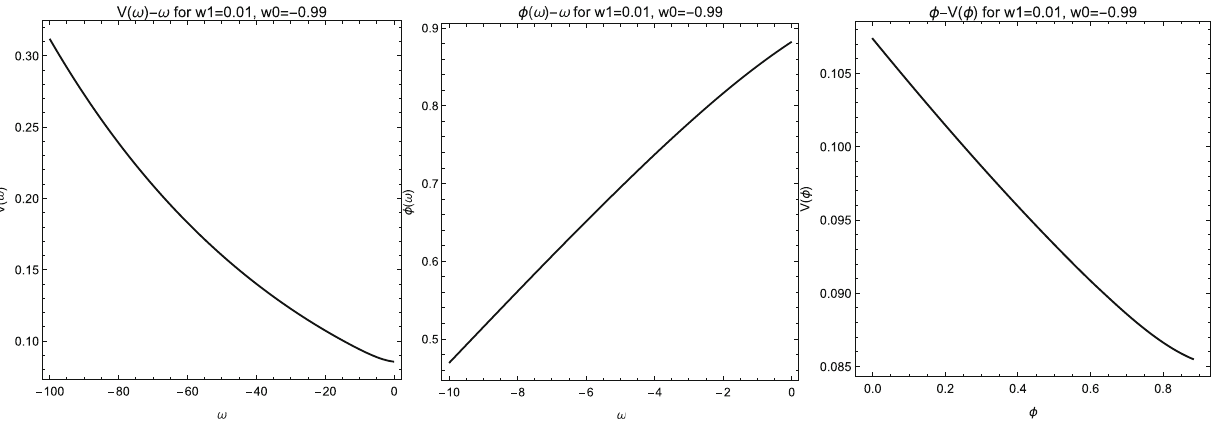
Fig. 5 Qualitative evolution of the scalar field φ (ω), the scalar field potential V (ω) as also the parametric plot φ − V (φ) is given for the Ext3